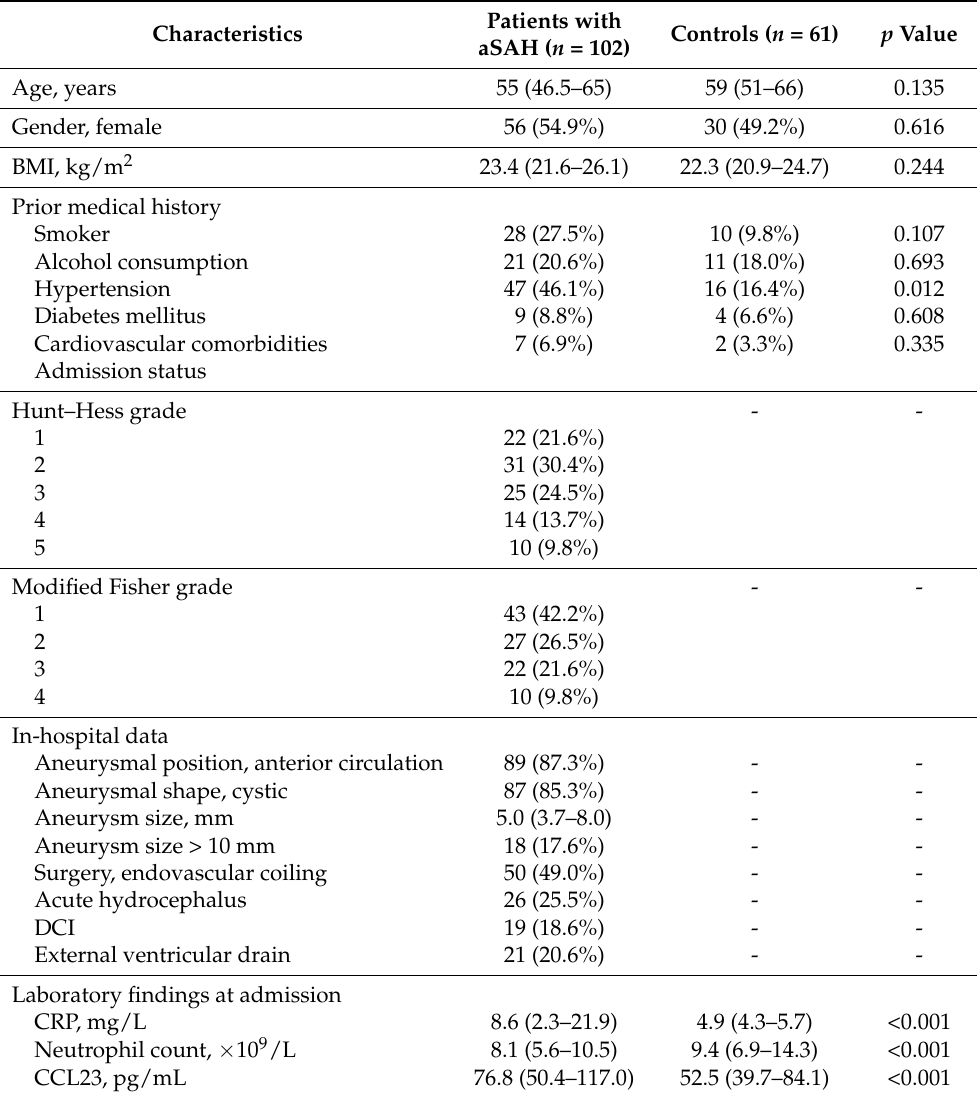
Table 1. Baseline characteristics of the study